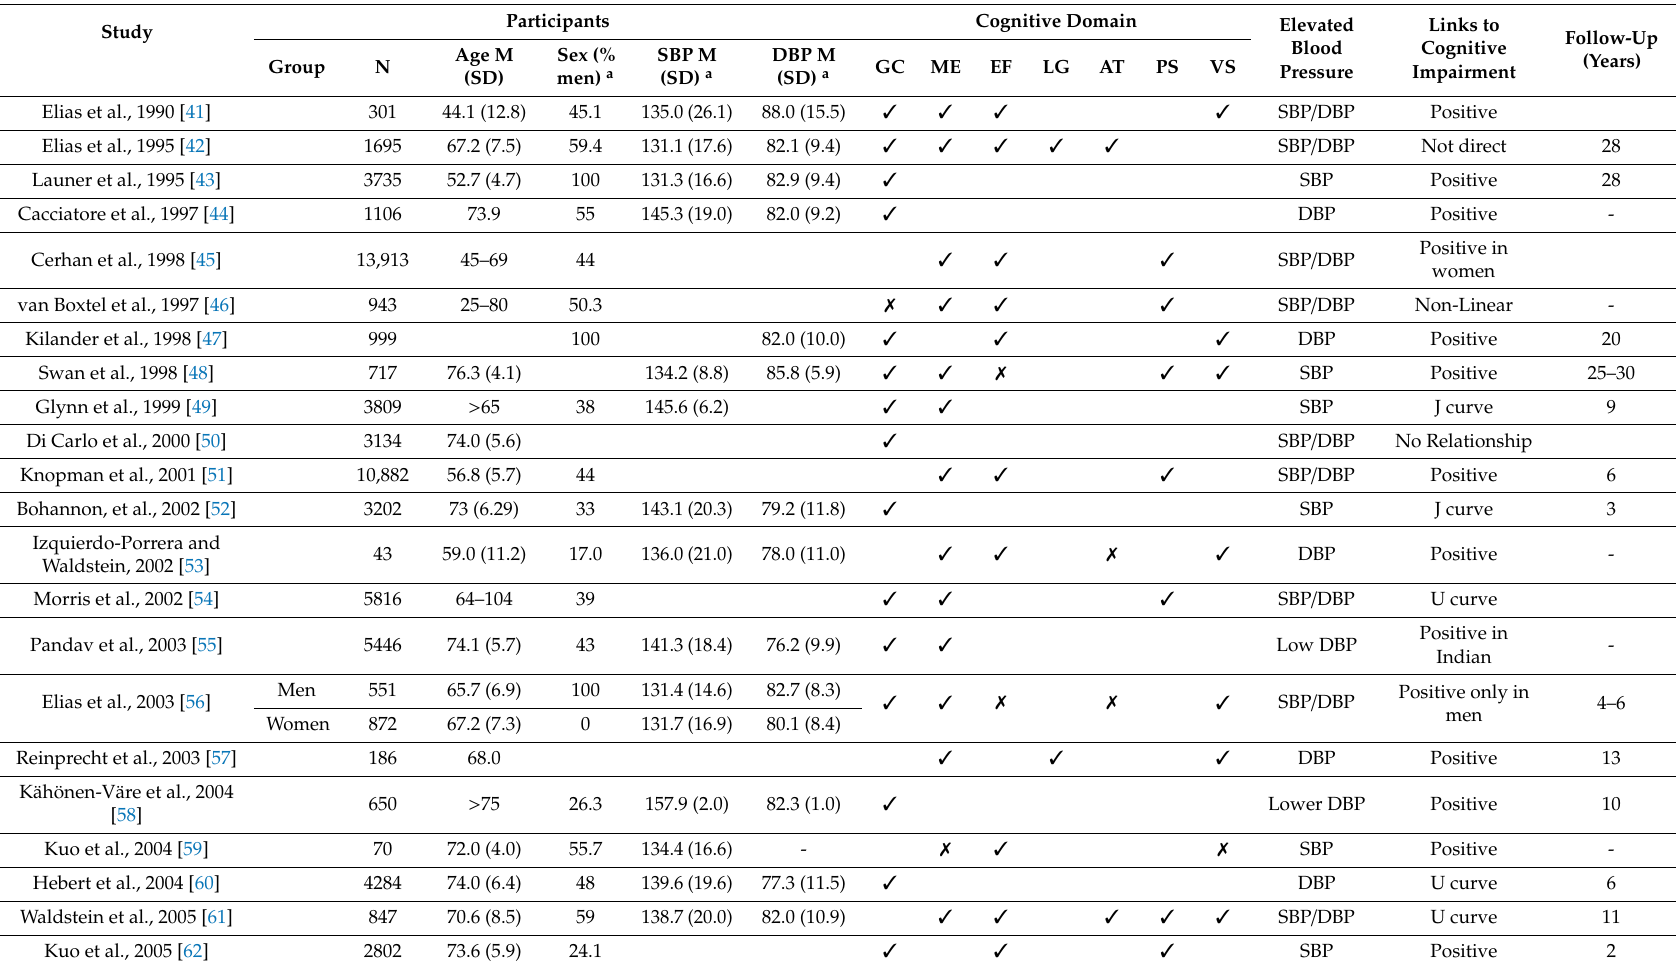
Table 2. Characteristics of the selected